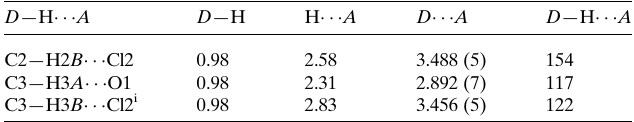
Table 2 Hydrogen-bond geometry (A˚ , (cid:3) ) for 4 .